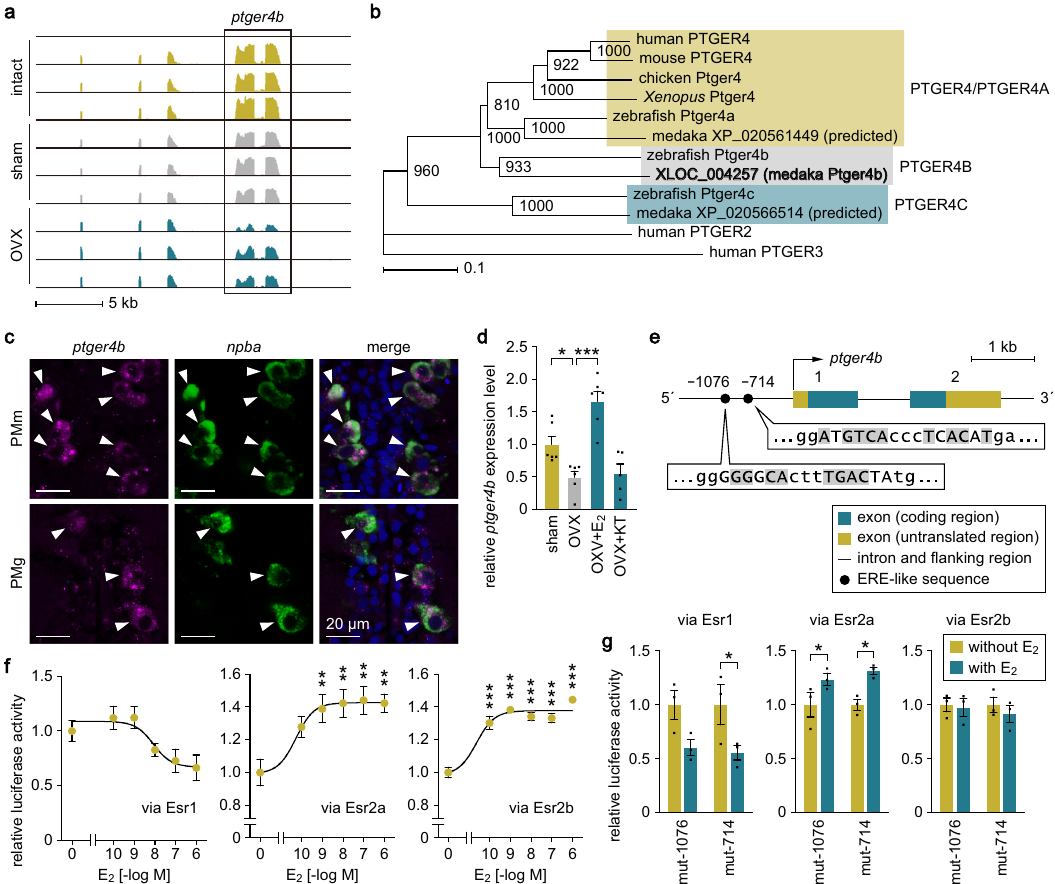
Fig. 2 ptger4b is expressed in FeSP neurons in an ovarian estrogen-dependent manner. a Integrative genomics viewer (IGV) images of RNA-seq reads from FeSP neurons of intact, sham-operated (sham), and ovariectomized (OVX) females ( n = 3 for each treatment) for ptger4b . b Phylogenetic tree showing the relationship of medaka Ptger4b to other known PGE 2 receptor 4 proteins. The number at each node indicates bootstrap values for 1000 replicates. Scale bar represents 0.1 substitutions per site. For species names and GenBank accession numbers, see Supplementary Table 1. c Representative micrographs showing the expression of ptger4b in FeSP neurons in the PMm (upper panels) and PMg (lower panels). Left and middle panels show images of ptger4b (magenta) and npba (green) expression, respectively, in the same section; right panels show the merged images with nuclear counterstaining (blue). Arrowheads indicate representative FeSP neurons expressing ptger4b . Scale bars represent 20 μ m. d Levels of ptger4b expression in FeSP neurons of sham females and OVX females exposed to vehicle only (OVX), estradiol-17 β (OVX + E 2 ), or 11-ketotestosterone (OVX + KT) as determined by real- time PCR ( n = 6 per treatment except OVX + KT, where n = 5). Mean value of sham females was arbitrarily set to 1. e Genomic structure of ptger4b depicting the relative location of the two canonical bipartite estrogen-responsive element (ERE)-like sequences in the 5 ′ -proximal region. Bent arrow indicates the transcription start site. Numbers are shown above each exon. The nucleotide sequence of each ERE-like sequence is shown in uppercase letters. Nucleotides identical to the ERE consensus sequence (AGGTCAnnnTGACCT) are highlighted in gray. f Stimulation of ptger4b transcriptional activity by E 2 . CHO cells were transfected with a luciferase reporter construct containing a genomic fragment upstream of the fi rst methionine codon of ptger4b and an expression vector for either Esr1, Esr2a, or Esr2b. Cells were treated with different concentrations of E 2 , and luciferase activity was measured. Values are expressed as fold induction over unstimulated cells. g Effects of mutations in ERE-like sequences on the stimulation of ptger4b transcriptional activity by E 2 . Cells were transfected with a luciferase reporter construct carrying a mutation in the ERE-like sequences at position − 1076 (mut-1076) or − 714 (mut-714), together with the Esr1, Esr2a, or Esr2b expression construct. Cells were treated with or without E 2 and luciferase activity was measured. Values are expressed relative to cells without E 2 stimulation. Each assay was performed in triplicate and repeated independently three times, except for the dose-response assay with Esr2a, which was repeated six times. Quantitative data were expressed as means with error bars representing standard error of the mean. Statistical differences were assessed by Bonferroni ’ s post hoc test ( d ), Dunnett ’ s post hoc test (versus unstimulated control) ( f ), and unpaired t -test ( g ). * p < 0.05; ** p < 0.01; *** p < throughout the entire brain by in situ hybridization revealed that ptger4b was expressed in fi ve brain nuclei: expression in the Vv (ventral nucleus of the ventral telencephalic area) and PPa (anterior parvocellular preoptic nucleus) was common to both sexes; expression in Pbl (basal lateral preoptic nucleus) was male- speci fi c; and expression in the PPp (posterior parvocellular pre- optic nucleus) and PMm/PMg, where FeSP neurons reside, was female-speci fi c (Fig. 3a – c).